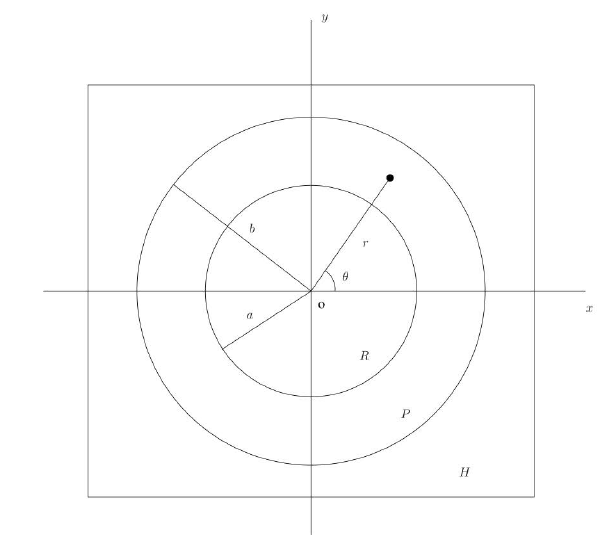
Figure 6. The crosssection of the coated fiber with core radius a and coating radius b